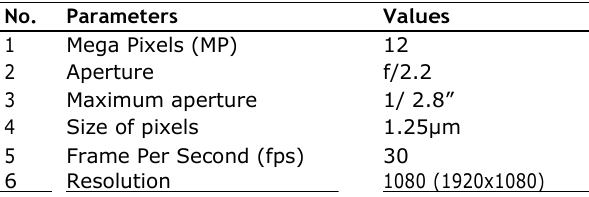
Figure 1. Huawei P10 Lite Table 1 Camera specification of Huawei P10 Lite